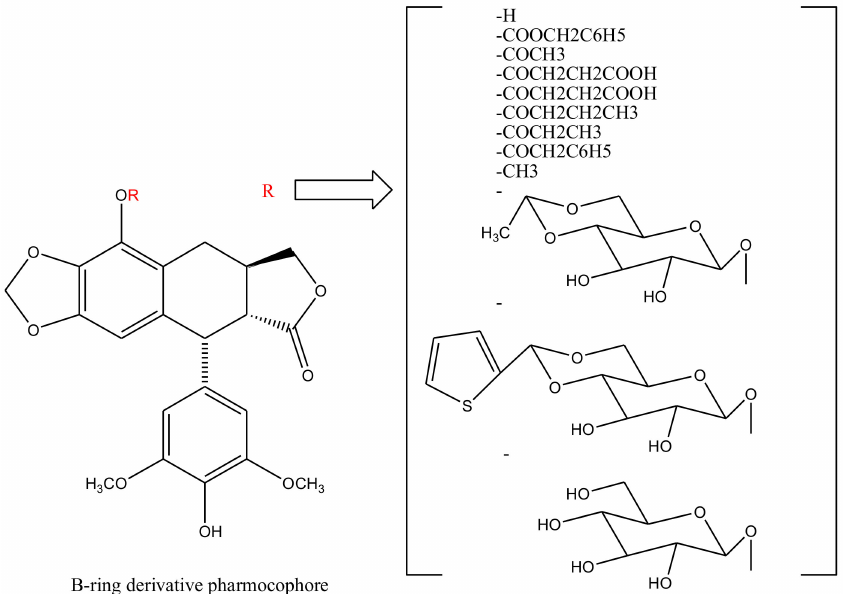
Figure 5. Structures of alpha-peltatin and beta-peltatin. These two B-ring modified podophyllotoxin derivatives are known to exhibit significant antiviral and antitumor activities. The B-ring modified pharmacophore was identified from these compounds and was taken further to synthesize more derivatives—as shown bracketed—none of which elicited any clinical